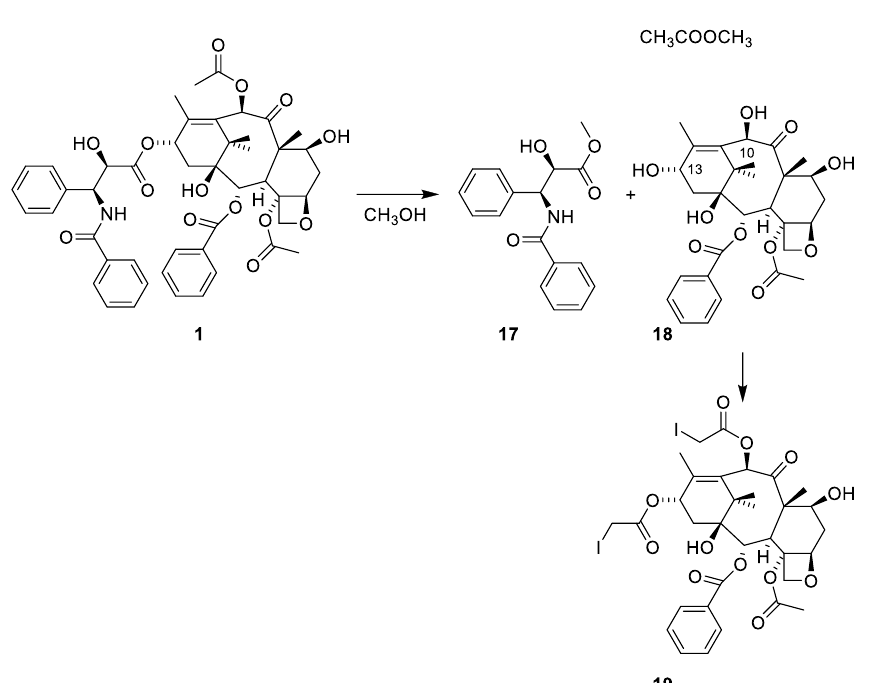
Figure 5. Methanolysis of paclitaxel ( 1 ) to give the tetraol ( 18 ) and the benzoylated phenylisoserine ester 17 . The structure of 18 was solved with an X-ray analysis of the diiodoacetyl ester 19 [38].